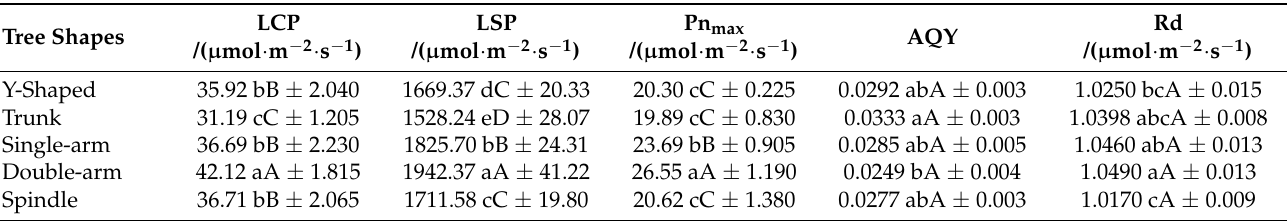
Figure 2. The effects of different tree shapes on the leaf area ( A ), chlorophyll content ( B ), net photosynthetic rate with the light intensity ( C ), and net photosynthetic rate with CO 2 ( D ). The error bar represents the standard deviation (SD). Different lowercase letters indicate statistically significant ( p < 0.05) differences between tree shapes. Table 3. Parameters of the photosynthetic light ‐ response curve.